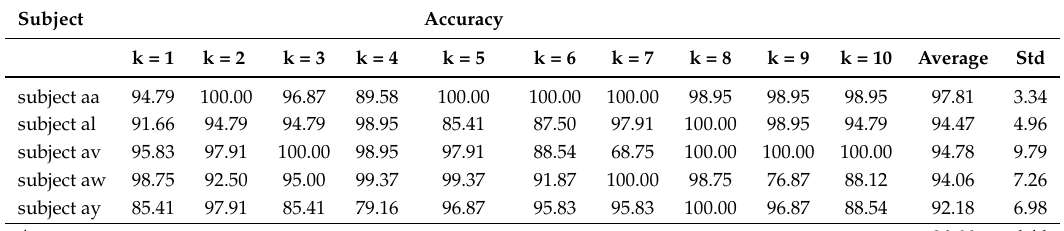
Table 2. 10-fold cross validation accuracy.